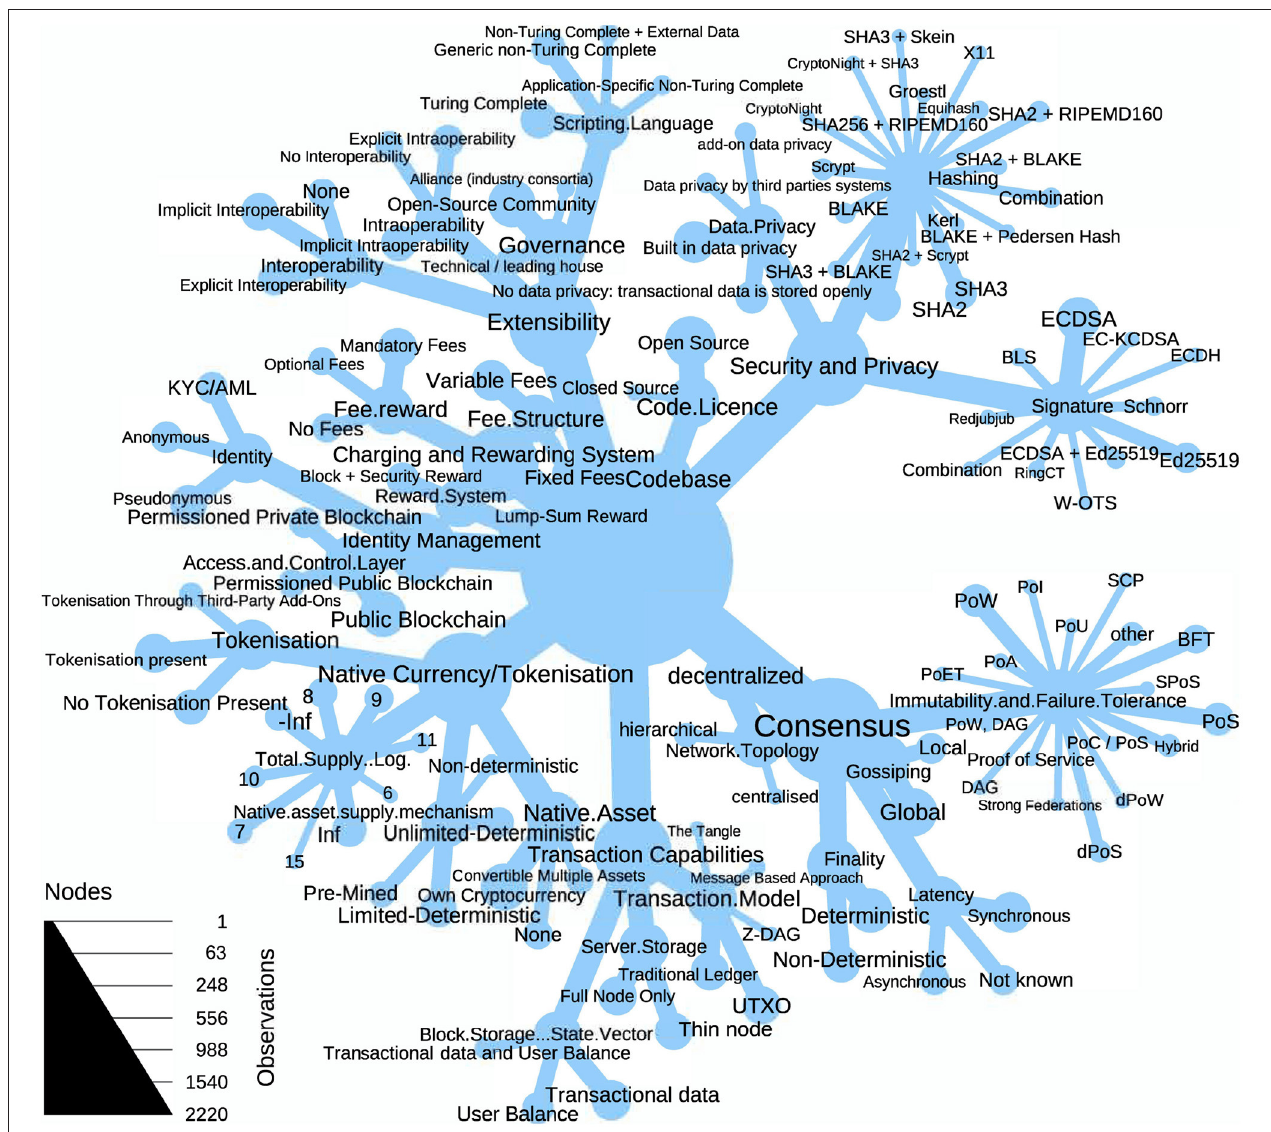
FIGURE 2 | The tree of blockchain illustrates the varying innovation activity within the components. The nodes represent the observations in the (sub)components and the links the connection to the sub-components resp. layouts.